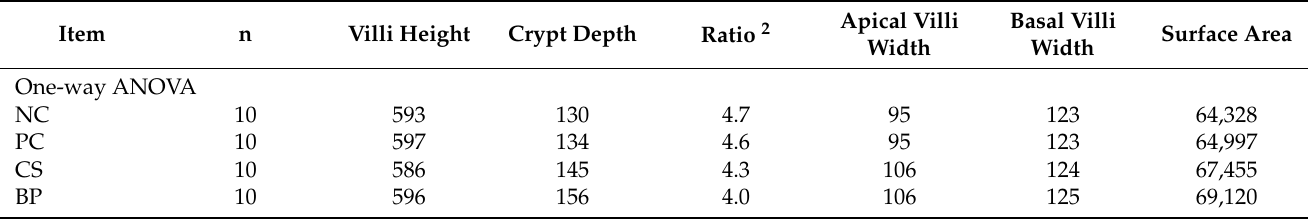
Table 7. Histological characteristics of jejunal tissue collected from broilers fed diets with and without bacitracin methylene disalicylate or various antibiotic alternatives 1